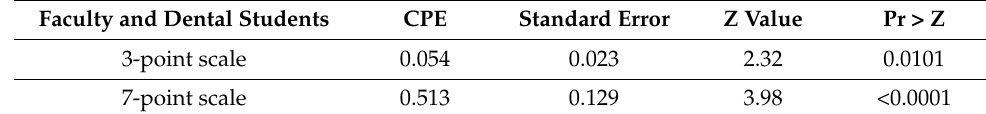
Table 1. Combined faculty and dental student covariance parameter estimates (CPE) for both scales.